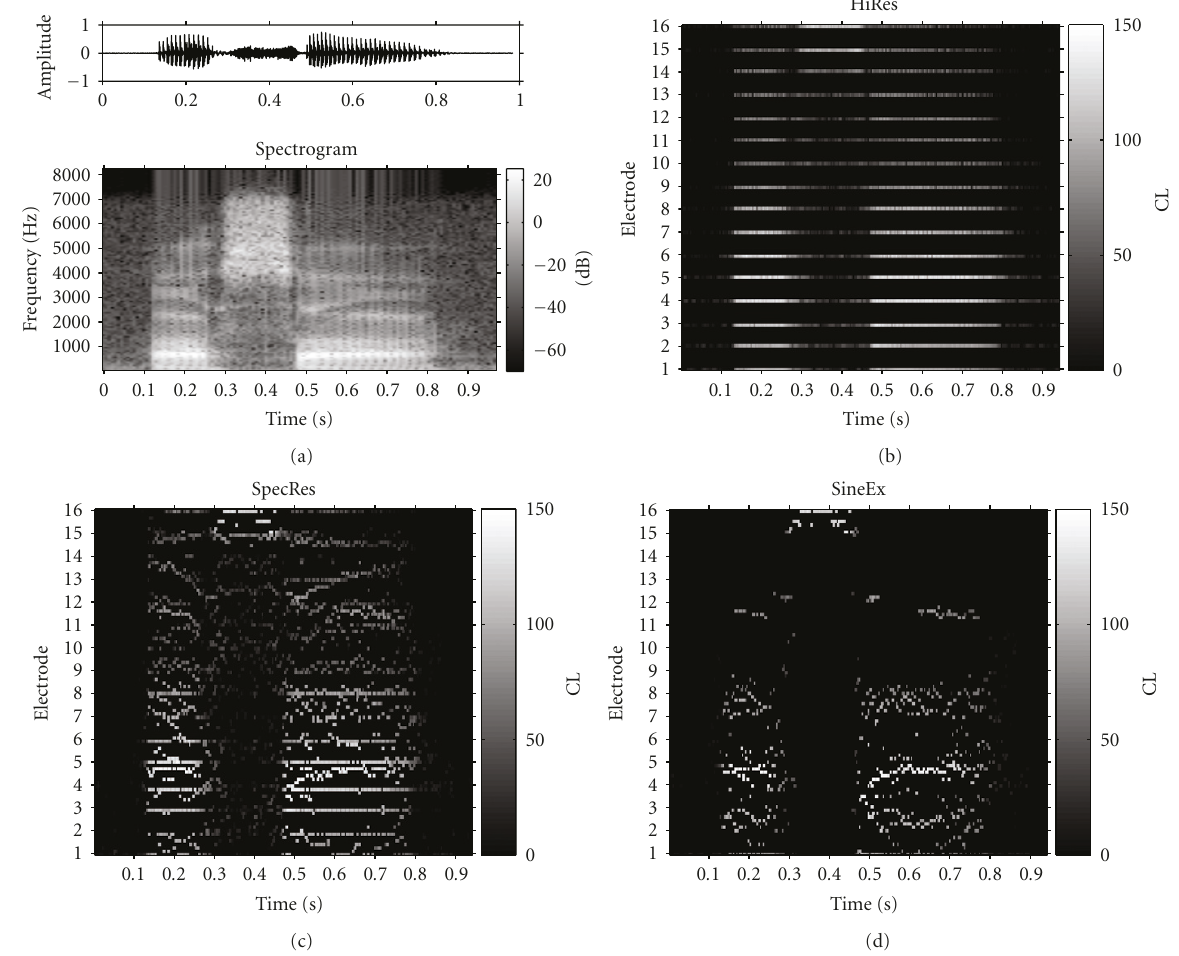
Figure 8: (a) Speech token “asa” uttered by a male voice and its spectrogram. (b) Stimulation pattern obtained with HiRes. (c) Stimulation pattern obtained with SpecRes. (d) Stimulation pattern obtained with SineEx. The horizontal axis represents time in seconds, and the vertical axis represents the electrode location. The level applied in current level (CL) is coded by the colors given in the color bars. The location of excitation is obtained by linearly interpolating the electrical amplitude applied to the pairs of simultaneous stimulated electrodes.